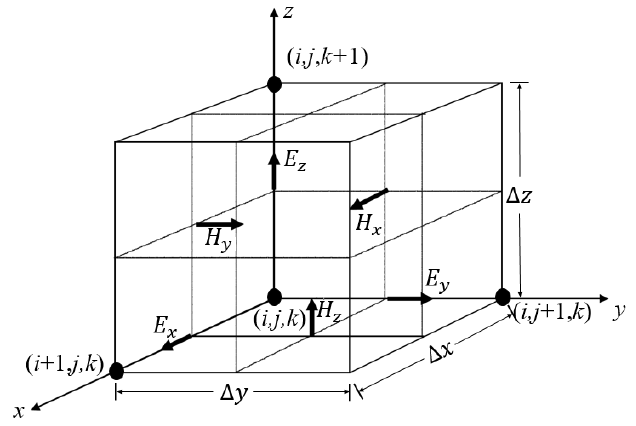
Figure 4. Representation of Yee cell in three-dimensional space.